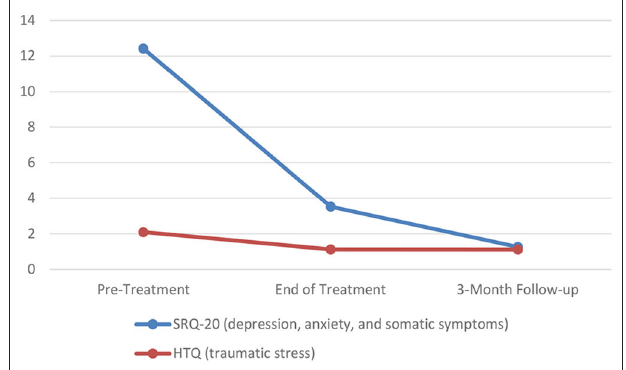
FIGURE 2 | Changes in symptoms over